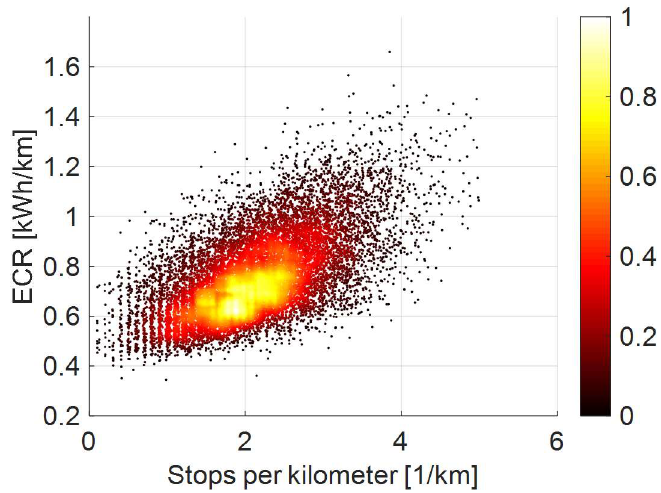
Figure 9. The correlation between stops per kilometer and ECR.